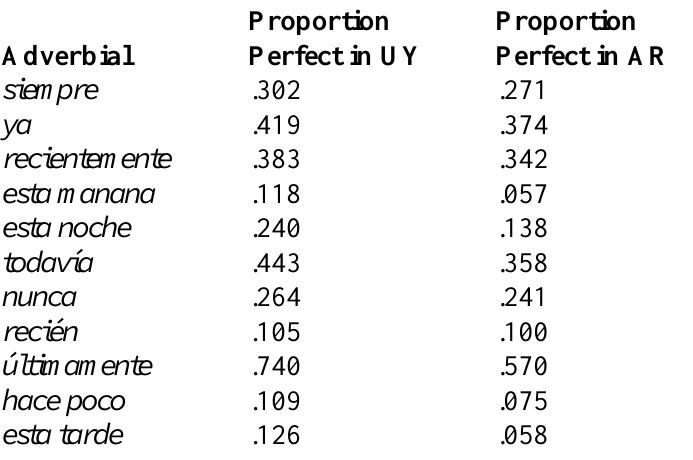
Table 6. Proportion of present perfect versus preterite appearing before or after adverbial